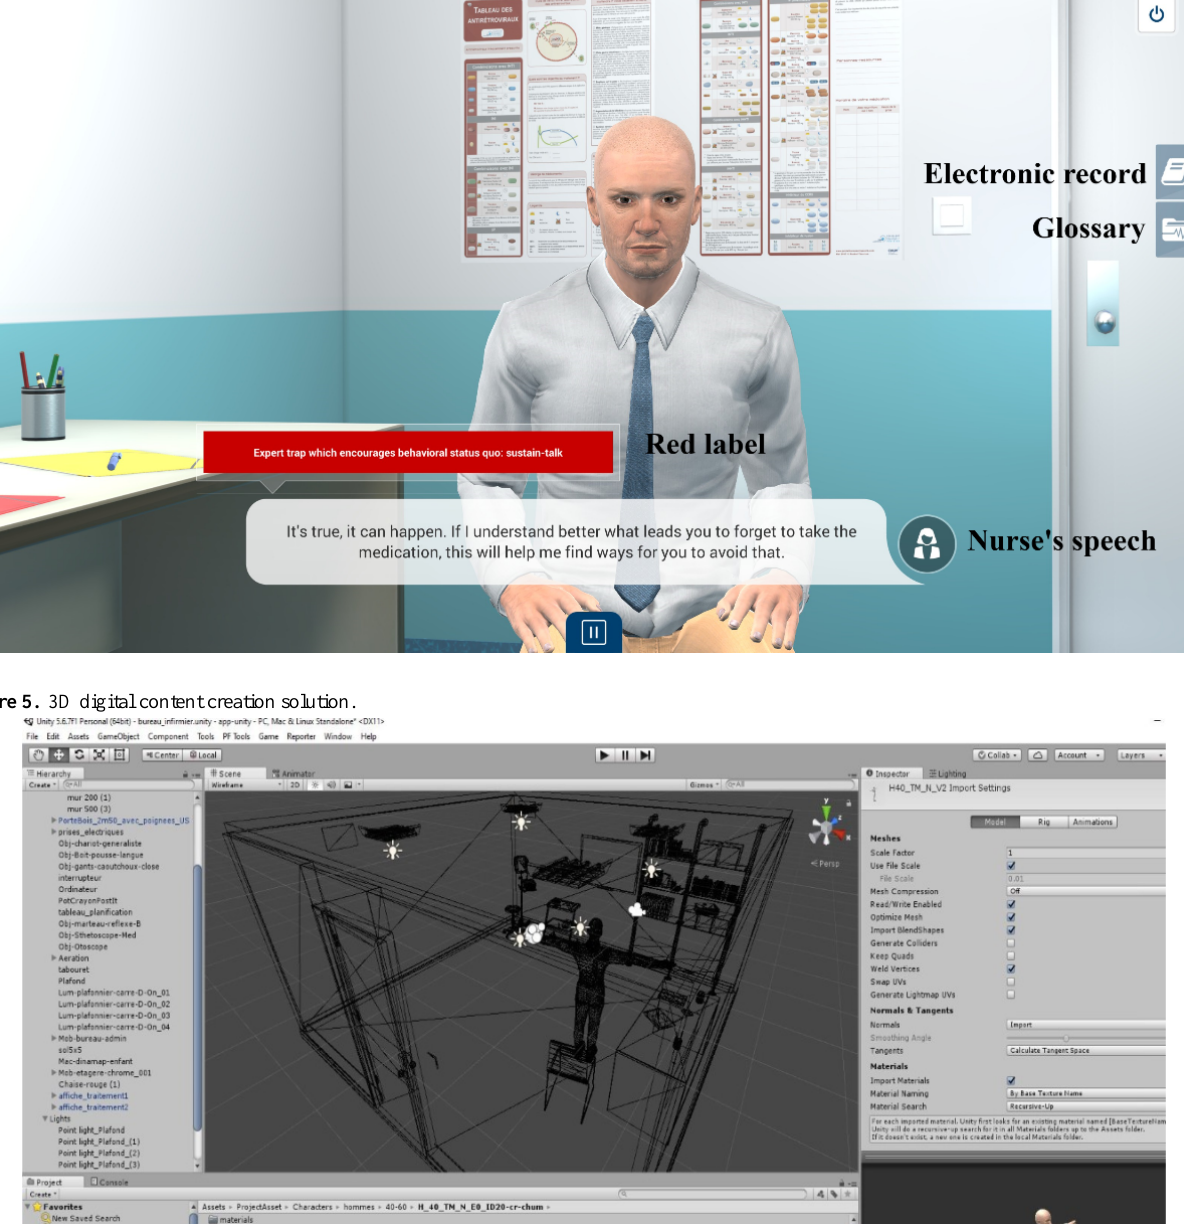
Figure 4. Final design of the virtual patient simulation.